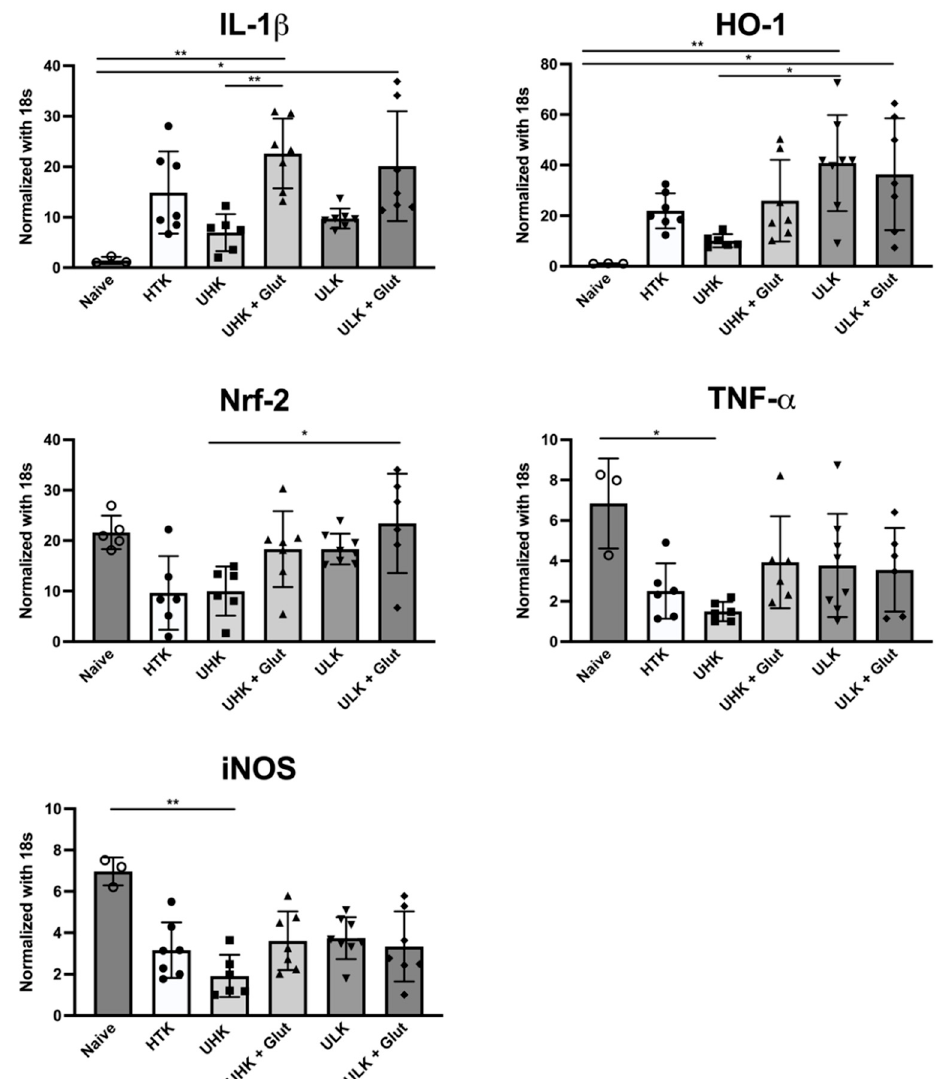
Figure 6. Expression analysis. Expression of pro- and anti-inflammatory markers IL-1 β , TNF- α , HO-1, Nrf-2, and iNOS in cardiac tissue three days after heterotopic cardiac transplantation using qPCR. Cardiac tissues of naïve animals and heterotopically transplanted hearts subjected to 18 h of SCS that were treated with either HTK, UHK, UHK + Glut, ULK, or ULK + Glut were analyzed (naive control n = 3; others n = 6–8/group) using the Kruskal–Wallis test and Dunn’s multiple comparison test. Unisol, gluconate-lactobionate-dextran; HTK, histidine-tryptophan ketoglutarate solution; UHK, Unisol-high-potassium; ULK, Unisol-low-potassium; Glut, glutathione. * p < 0.05, ** p < 0.01.